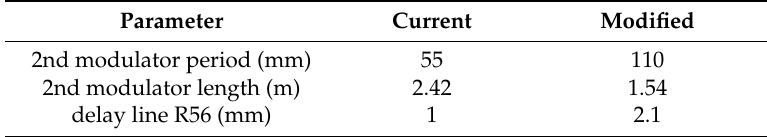
Table 2. Upgrades of the FEL-2 beamline planned for the EEHG experiment at 5.2